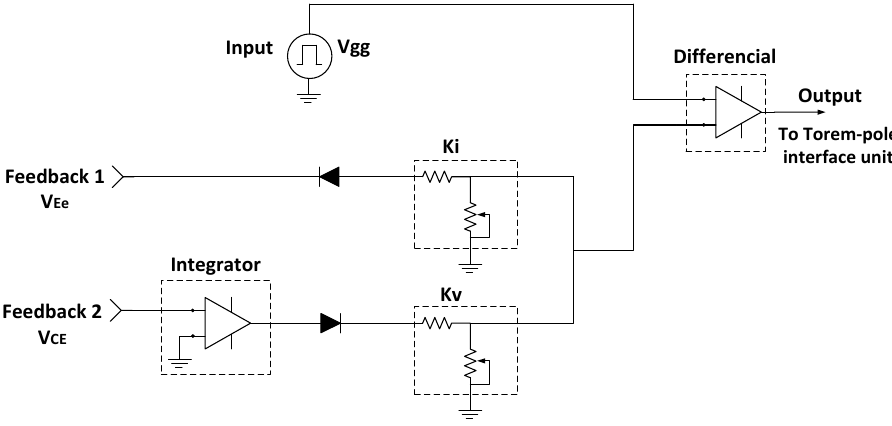
Figure A1. The schematic of the proposed closed-loop controller.